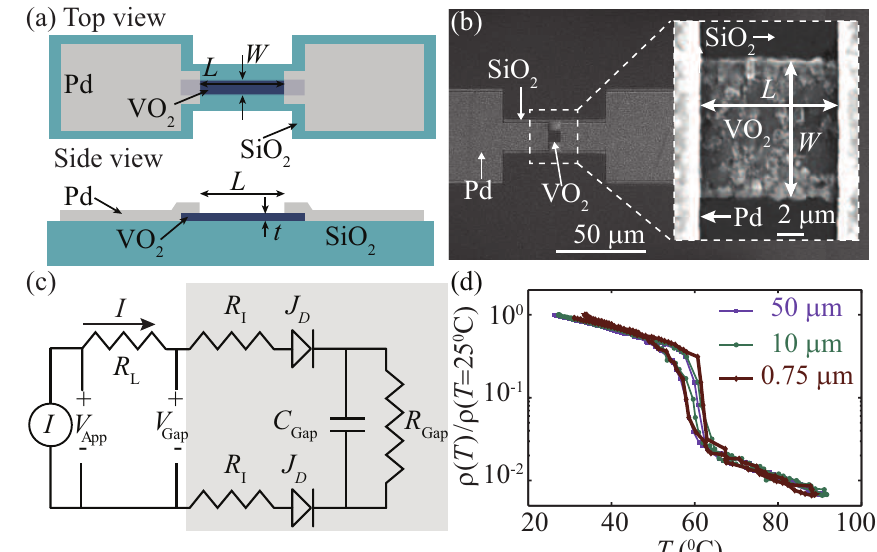
Figure 2. ( a ) The top and side view schematics of a VO electron micrograph of the device and (inset) the magnified image of the gap. ( c ) The equivalent circuit model of the device in the experiment. ( d ) The normalized resistivity of different microwires measured as the substrate temperature, T , for W = 5 µ m and L = 750 nm, 10 µ m and 50 µ